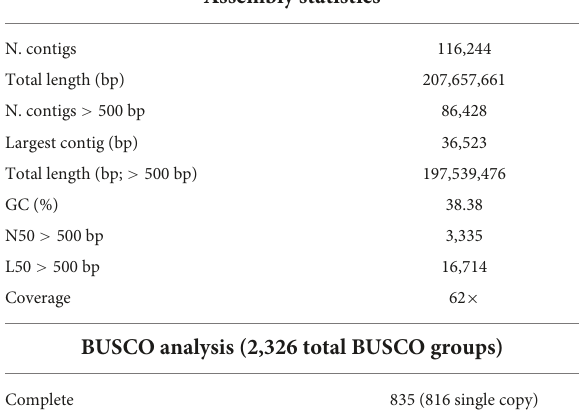
TABLE 2 Assembly statistics and BUSCO analysis